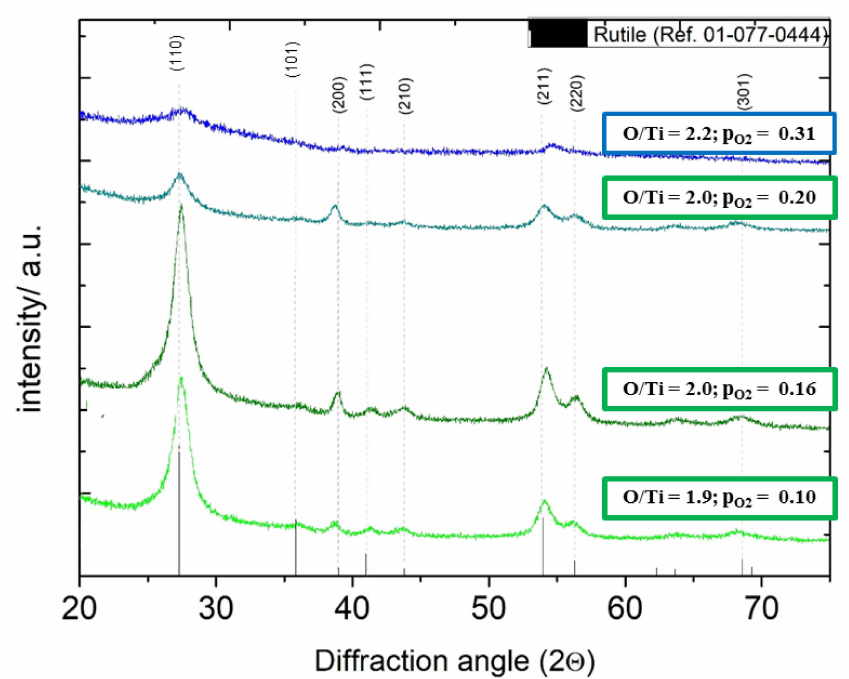
Figure 6. Glancing incidence XRD patterns for samples of G2, and a representative sample of G3. Rutile-type TiO 2 reference peaks are included in the